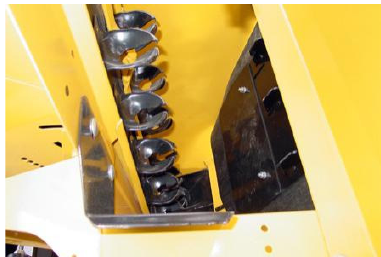
Figure 7. Cup-belt type. Reprinted with permission from ref. [49]. Copyright 2019 Miedema Industries.